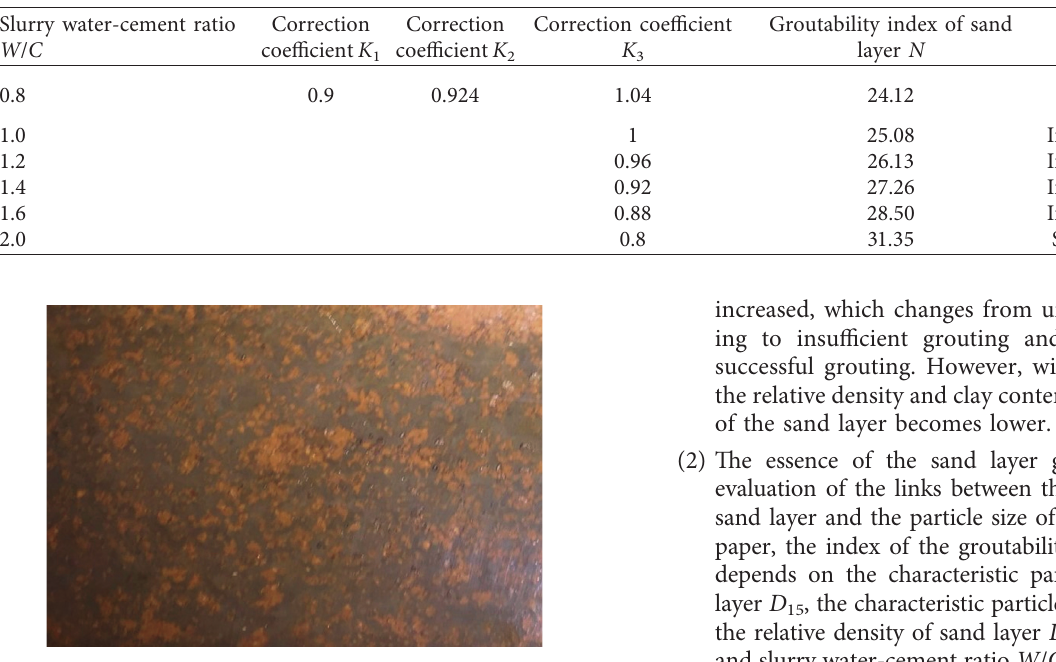
Table 7: Calculation results of the sand layer groutability.